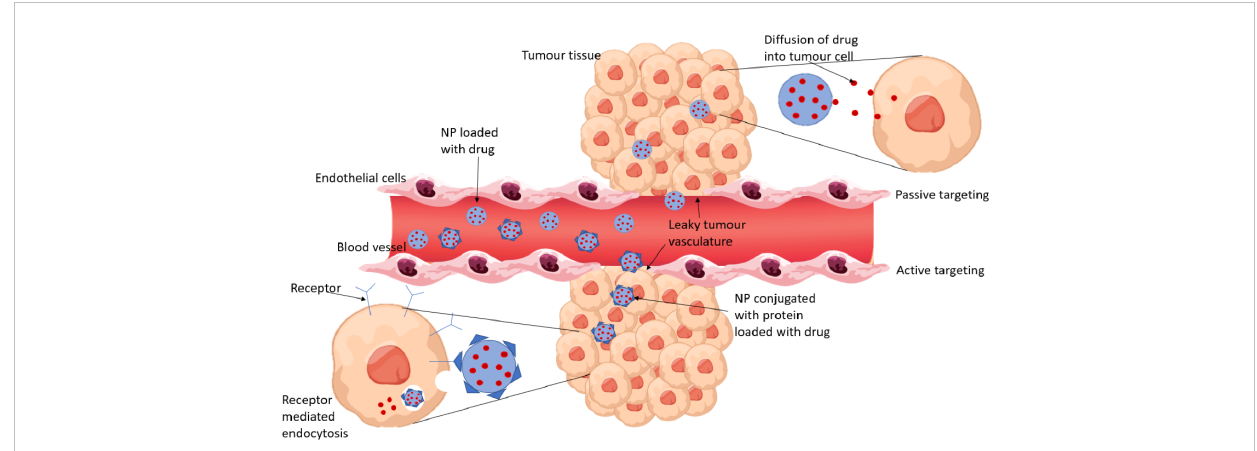
FIGURE 1 A comparison of passive and active drug targeting. Passive targeting relies on the EPR effect for NPs to accumulate in tumor tissue and release the encapsulated drug to the cells by diffusion. Active targeting involves conjugating proteins to the NPs which bind to receptors that are overexpressed by tumor cells. The NP enters the tumor cell by receptor mediated endocytosis and the drug is